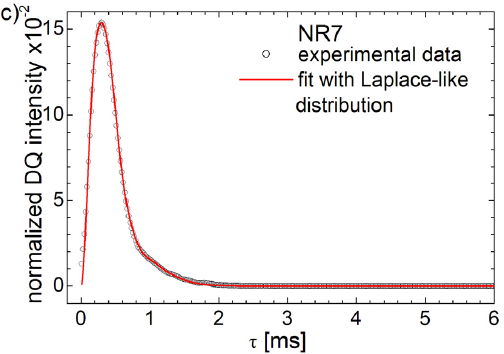
Figure 9. The experimental 1 H DQ build-up curves (open circles) and fits (continuous line) using the Laplace-like inversion procedure for ( a ) NR1, ( b ) NR4 and ( c ) NR7 cross-linked natural rubber six years natural aged.